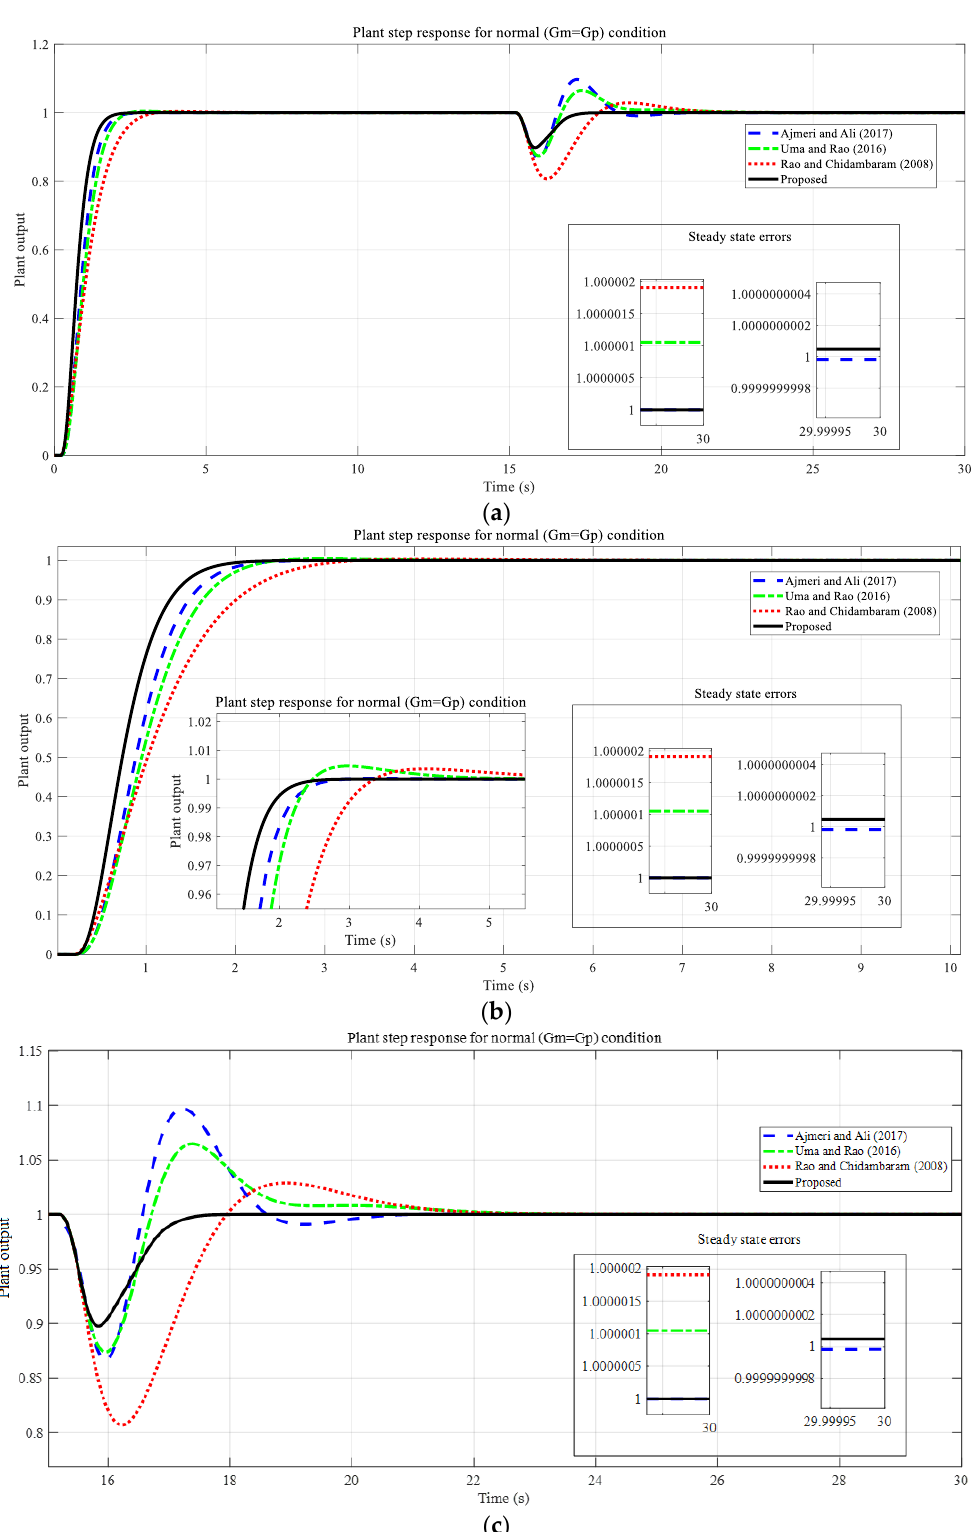
Figure 13. Closed loop performances of the proposed method and other methods for Example 3. ( a ) Set-point tracking and disturbance rejection, ( b ) magnified set-point tracking, and ( c ) magnified disturbance rejection [15,16,18].